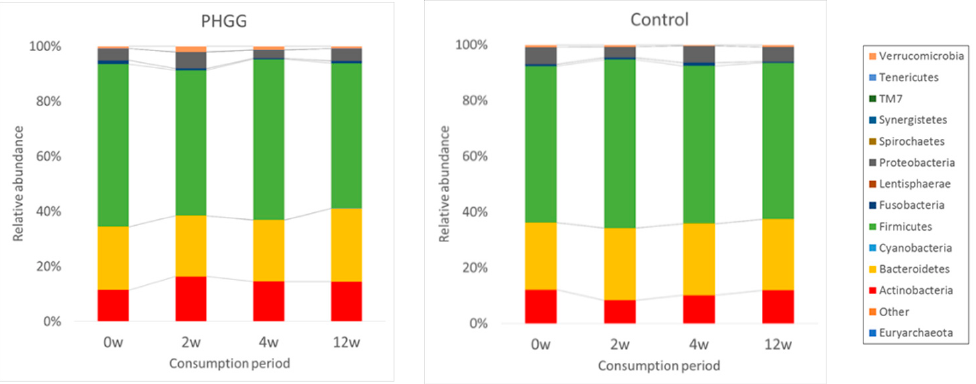
Figure 4. Comparative analyses of the taxonomic composition of the microbial community at the